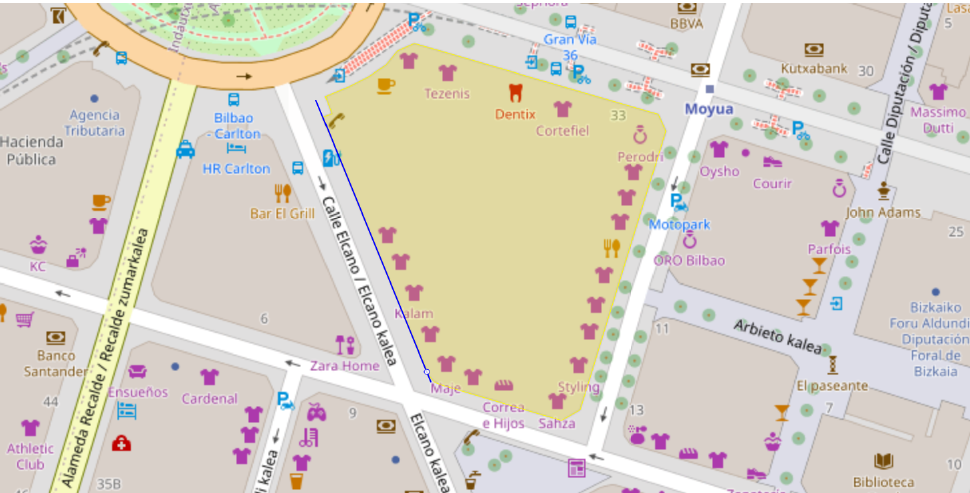
Figure 16. The point of the shop projected on the edge.